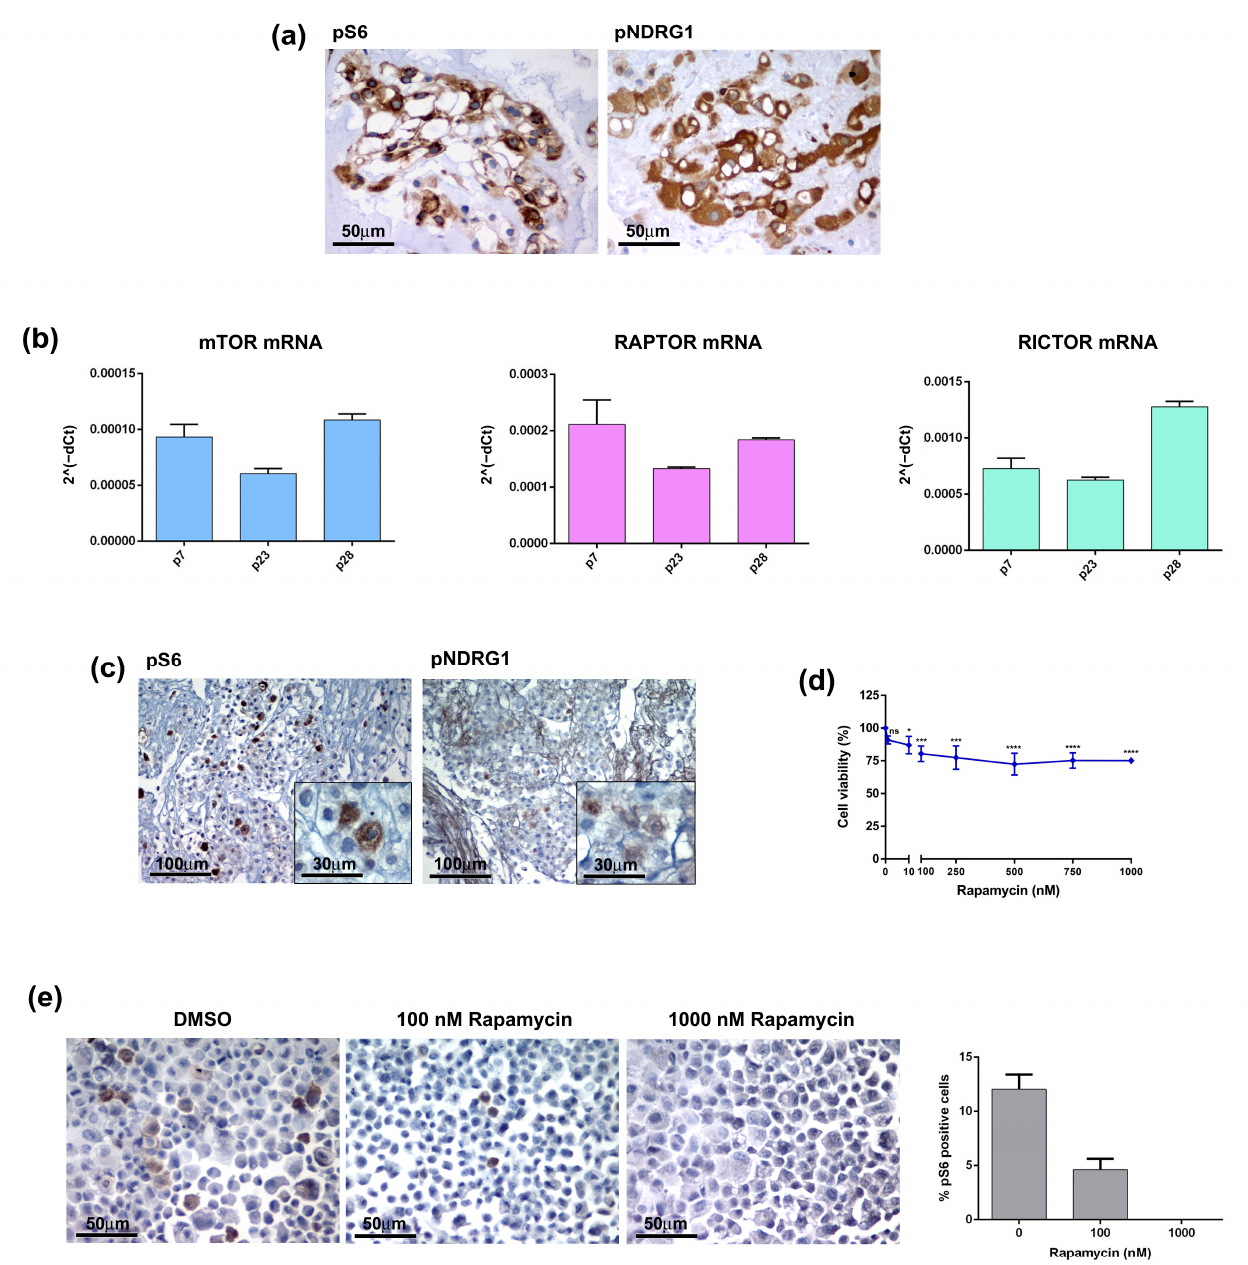
Figure 5. The mTOR pathway in chordoma tumour and cell line. ( a ) The mTOR pathway is activated in patient-derived chordoma tissue. The expression of mTOR markers, pS6 and pNDRG1, was analysed by IHC on FFPE tissue. ( b ) The CH3 cell line expresses mRNA of mTOR components. The mRNA expression of mTOR, Raptor and Rictor was analysed by quantitative real-time PCR. Bars and error bars represent mean values and standard deviation, respectively. ( c ) The markers of the mTOR pathway are expressed in the chordoma cell line. The expression of pS6 and pNDRG1 was analysed by IHC on FFPE cell blocks. ( d ) The mTOR inhibitor affected the CH3 cell viability. Cells were treated with 0–1000 nM Rapamycin for 10 days, the cell viability was analysed by MTT. Points and error bars on the curve represent mean values and standard deviation, respectively. ns, non-significant, * p < 0.05, *** p < 0.001, **** p < 0.0001. ( e ) Rapamycin affected the pS6-positive cells. Cells were treated with Rapamycin for 10 days, the pS6 expression was analysed by IHC and pS6 positive cells were quantified by ImageJ software.